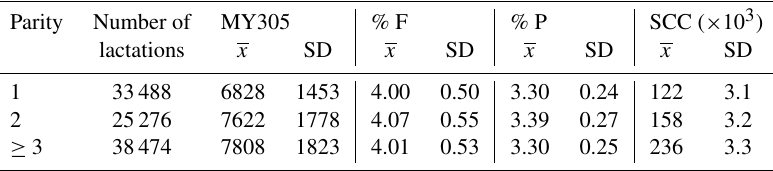
Table 1. Some descriptive statistics of data: number of lactations, average milk yield in standard lactation (MY305, kg), fat (% F), protein (% P), and geometric mean of the somatic cell count (SCC).